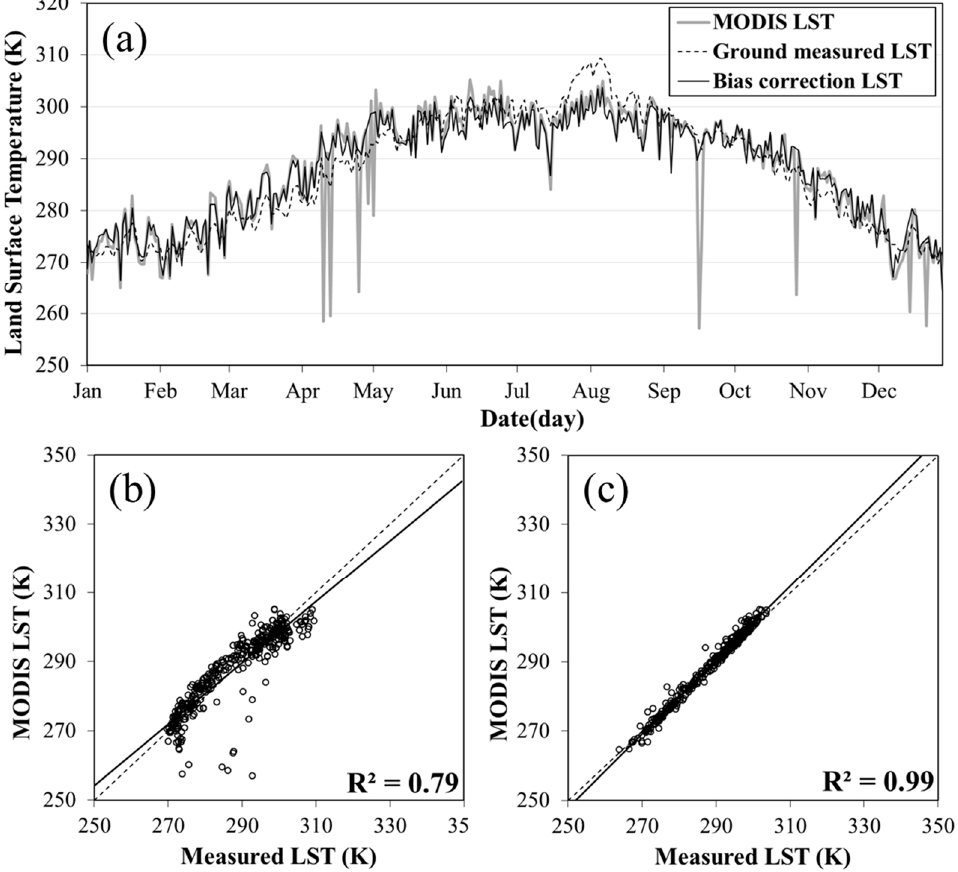
Figure 3. Time series and scatter plots of the MODIS and ground measured LST in 2012: ( a ) comparison of the MODIS and ground measured LSTs; ( b ) scatter plot of the data before calibration; and ( c ) scatter plot of the data after calibration.